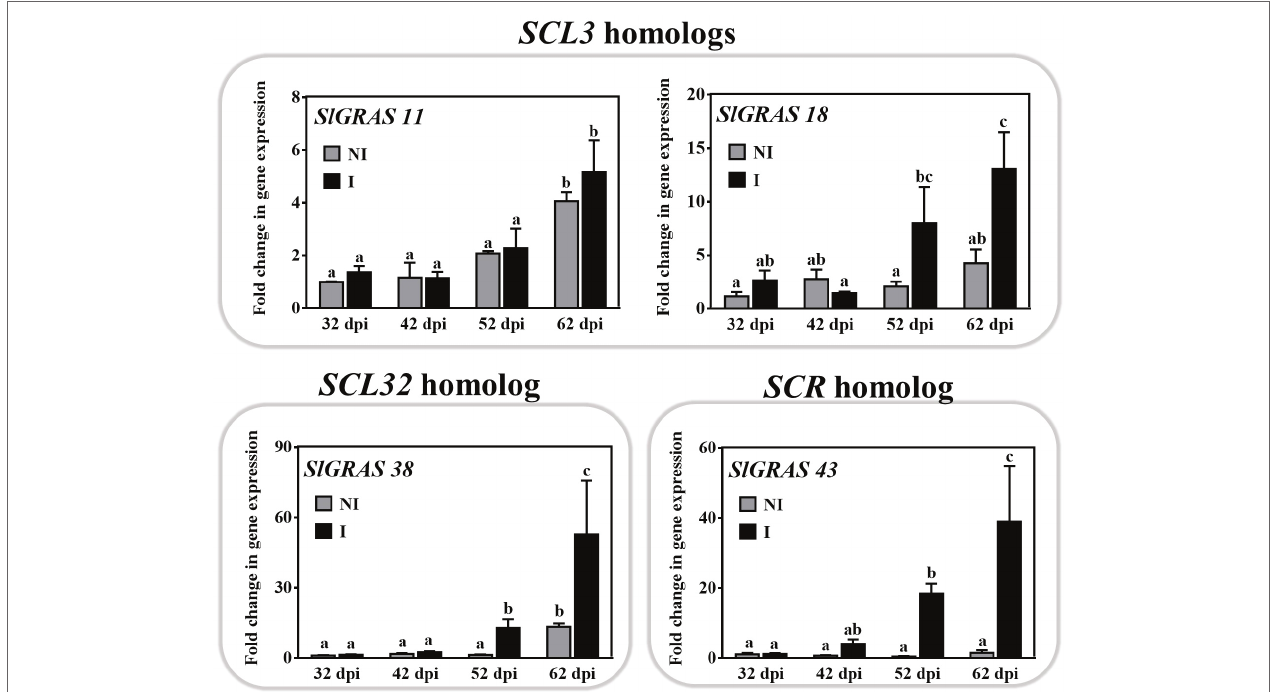
FIGURE 5 | Time-course expression of GRAS11 , SlGRAS18 , SlGRAS38 , and SlGRAS43 genes during mycorrhization in tomato roots. The expression of putative GRAS genes from SCL3, SCL32, and SCR families, thus far not reported to be related to mycorrhizal symbiosis, was analyzed by qPCR in roots after 32, 42, 52, and 62 dpi (days post inoculation) with the AM fungus R. irregularis . The qPCR data represent relative gene expression in the roots of AM-inoculated plants (I) with respect to their expression in non-inoculated (NI) plants at 32 dpi with a designated gene expression of 1. Values correspond to mean ± SE ( n = 3). Bars with the same letter are not significantly different ( p > 0.05) according to the LSD multiple comparison test.